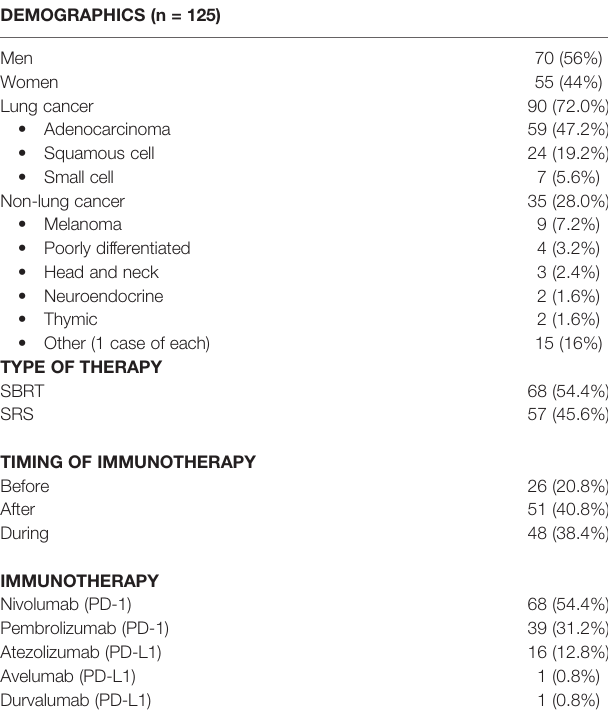
TABLE 1 | Patient demographics including sex, cancer type (divided into subclassi fi cations for lung cancer), type of radiation therapy, timing of immunotherapy, and exact immunotherapy